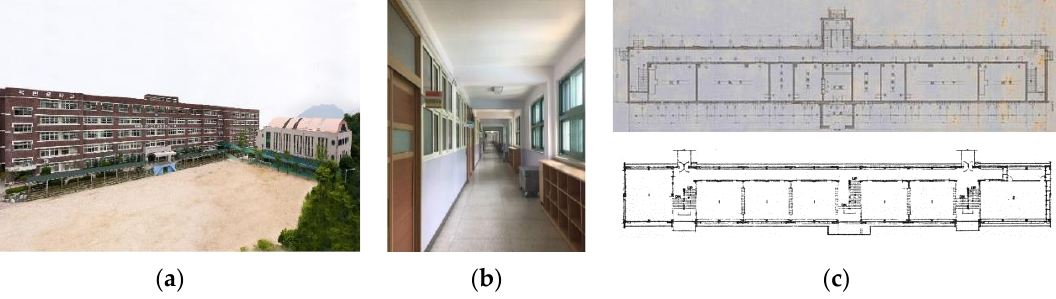
Figure 1. General appearance of Korean school facilities: ( a ) Exterior; ( b ) Interior; ( c ) Plans from the early 1900s (above) and later (below) (Sources: [12 – 15]).